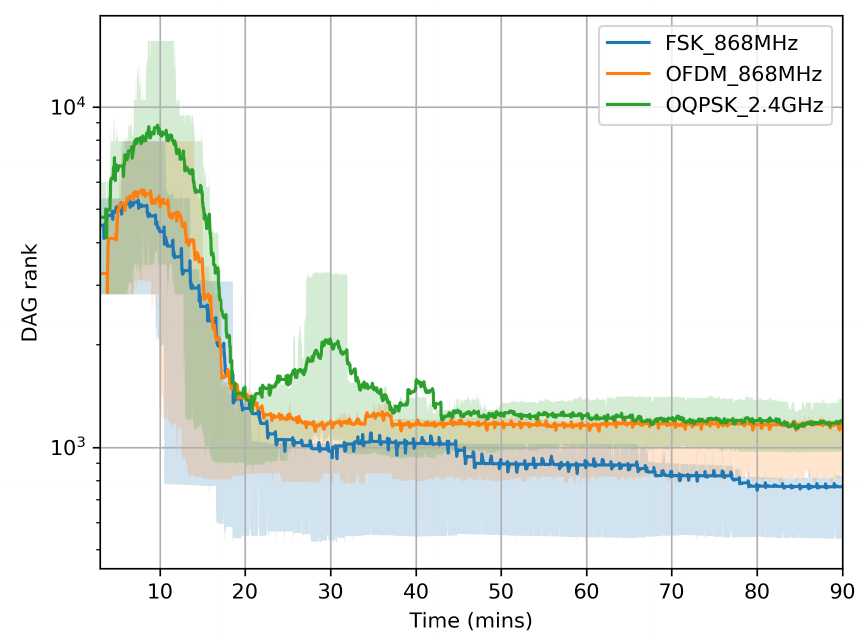
Figure 6. Contention and slow neighbor discovery cause the nodes’ rank to be artificially high at the beginning of network formation.